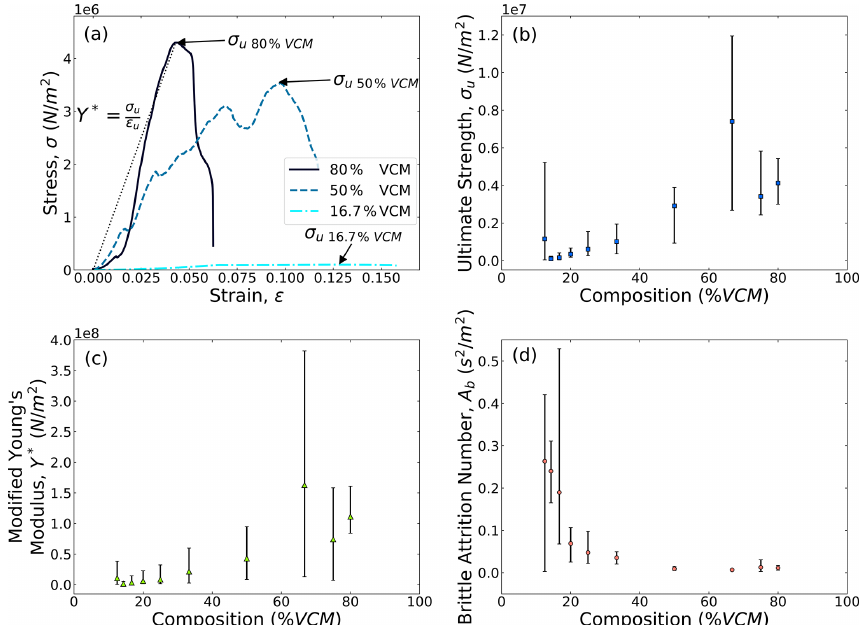
Figure 5. Material strength properties determined by uniaxial compression tests. (a) Stress–strain curves for concrete particles with varying proportions of concrete mix, as indicated by volume concrete mix (VCM). Ultimate strength, σ u [Nm − 2 ], is defined as the greatest stress withstood by the particle and is indicated on the stress–strain figure. Modified Young’s modulus, Y ∗ [Nm − 2 ], is calculated as the ultimate strength divided by the corresponding strain ( Y ∗ = σ u /(cid:15) u ). (b) Average ultimate strength for each particle composition, where error bars indicate the range of values produced by experiments ( n = 5). (c) Average modified Young’s modulus for each particle composition, where error bars indicate the range of values produced by experiments ( n = 5). (d) Average brittle attrition number, A b [s 2 m − 2 ], for each particle composition, where error bars indicate the range of values produced by experiments ( n =